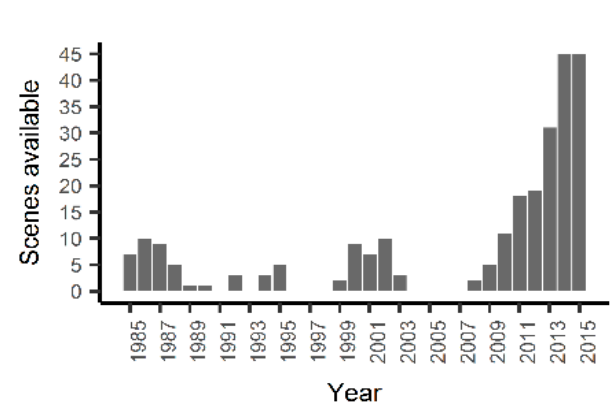
Figure A1. Landsat 5 and Landsat 7 scenes available for the study areas at the time of data analysis.